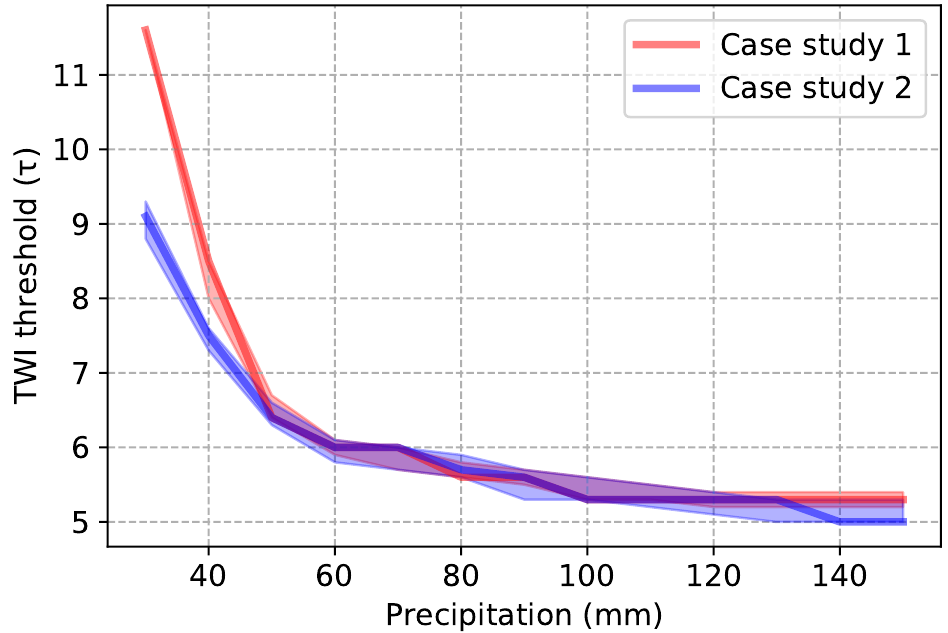
Figure 7. TWI threshold ( τ ) for the two case studies with the 99% confidence